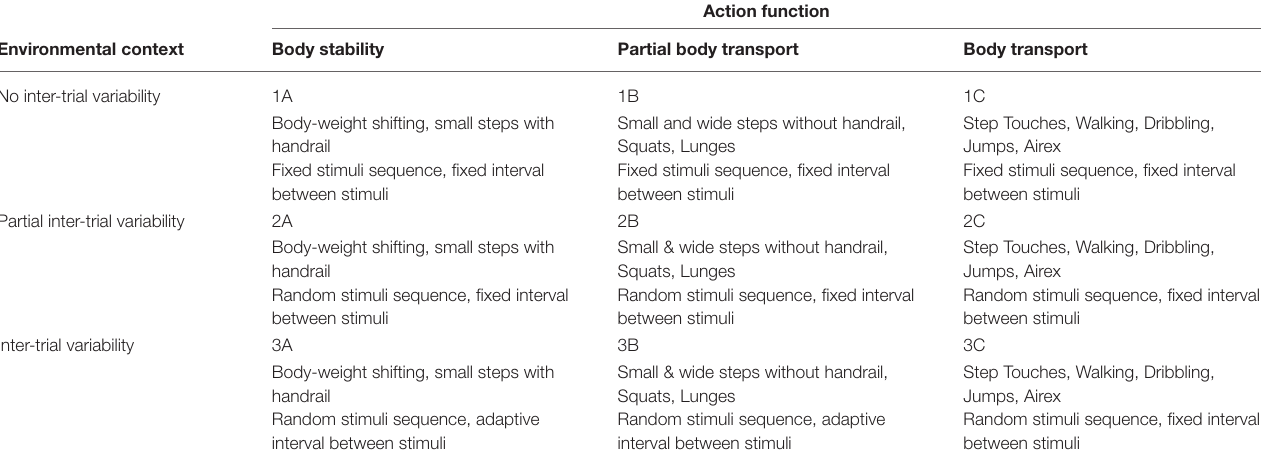
TABLE 1 | Adapted taxonomy with 9 motor skill categories (after step 1 of the